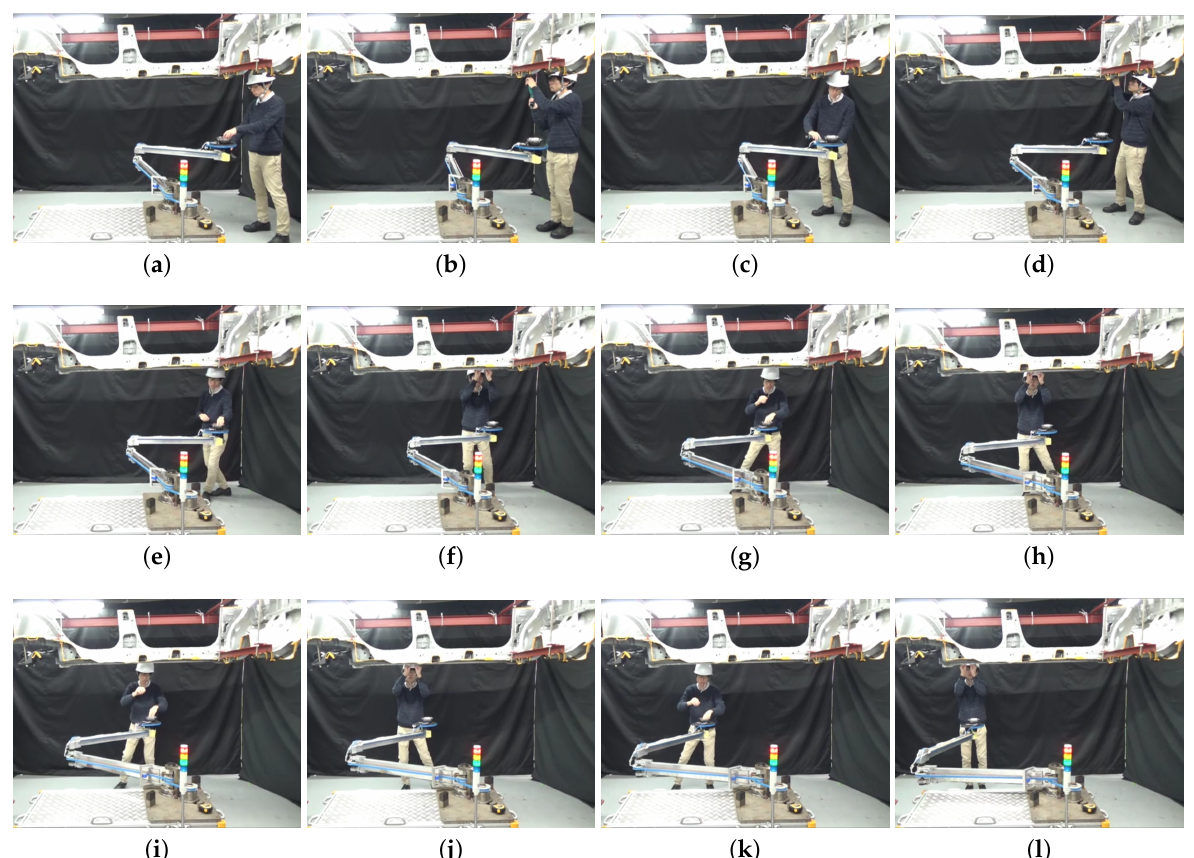
Figure 6. Experiment showing a complete work cycle where six tasks are performed. ( a ) A bolt and the tool are picked up; ( b ) Task 1 is performed; ( c ) The tool is returned and 3 grommets are picked up; ( d ) Task 2 is performed; ( e ) A grommet is picked up; ( f ) Task 3 is performed; ( g ) A grommet is picked up; ( h ) Task 4 is performed; ( i ) A grommet is picked up; ( j ) Task 5 is performed; ( k ) A grommet is picked up; ( l ) Task 6 is